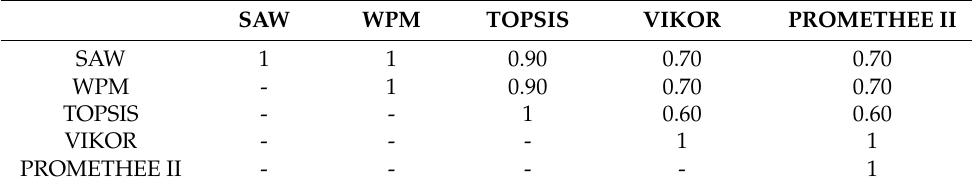
Table 9. Spearman’s correlation